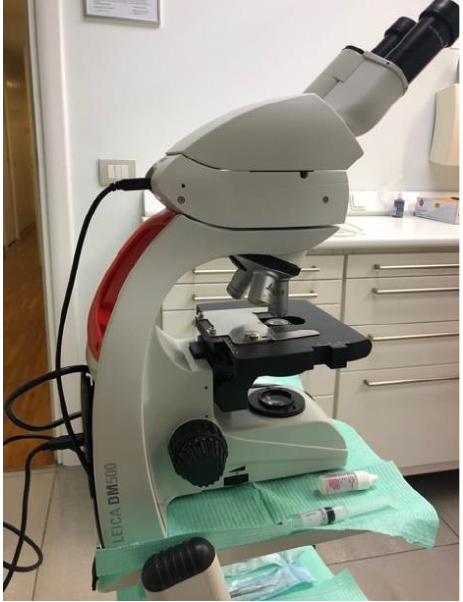
Figure 2. Contrast phase microscope in periodontal office.